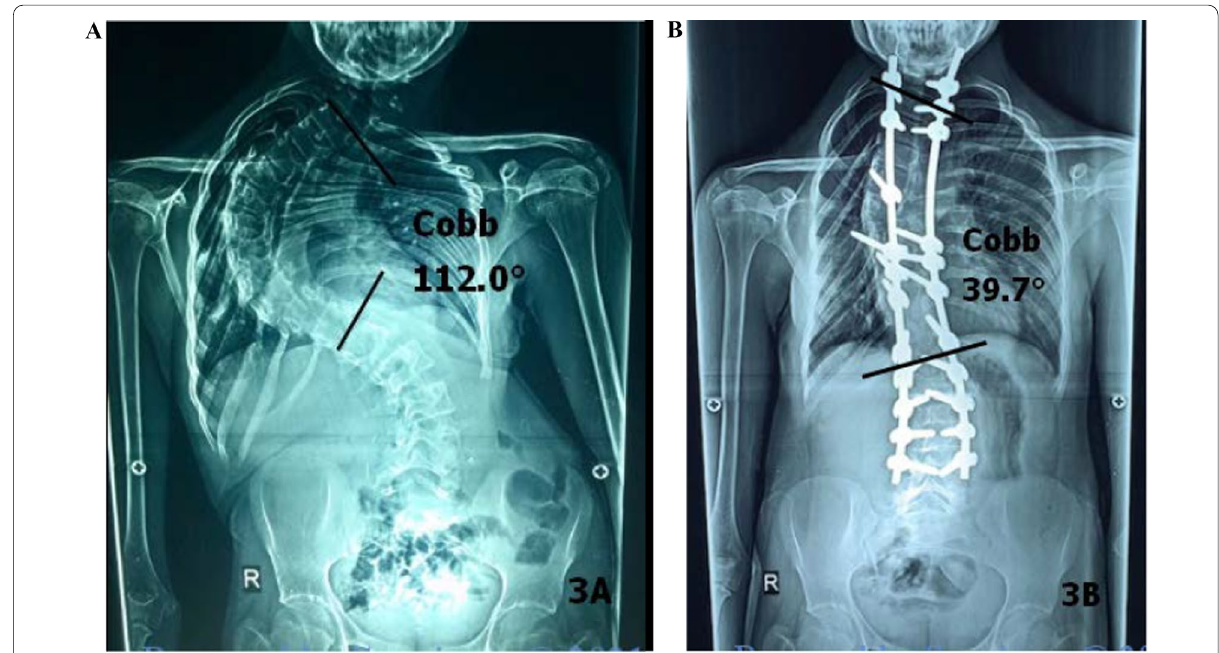
Fig. 3 A Plain X-ray (AP view) of the whole spine showing a main thoracic curve angle measures 112 degrees, in a 15-year-old female patient suffering from neuromuscular scoliosis (associated with Chiari type 1). B Postoperative plain X-rays (AP views) of the same case after 6 months showing correction of the main thoracic curve down to 40 degrees after Pvcr of the apex at